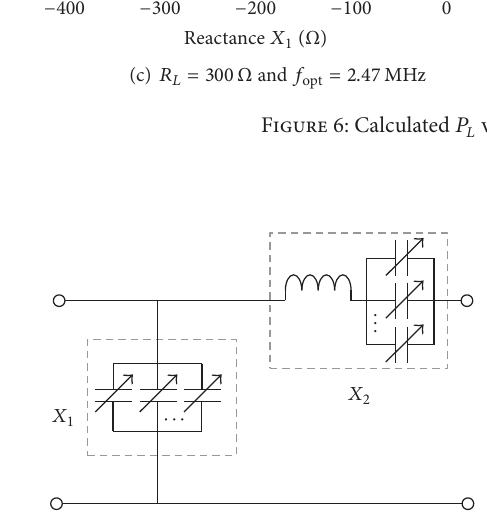
Figure 7: L-section IM network.